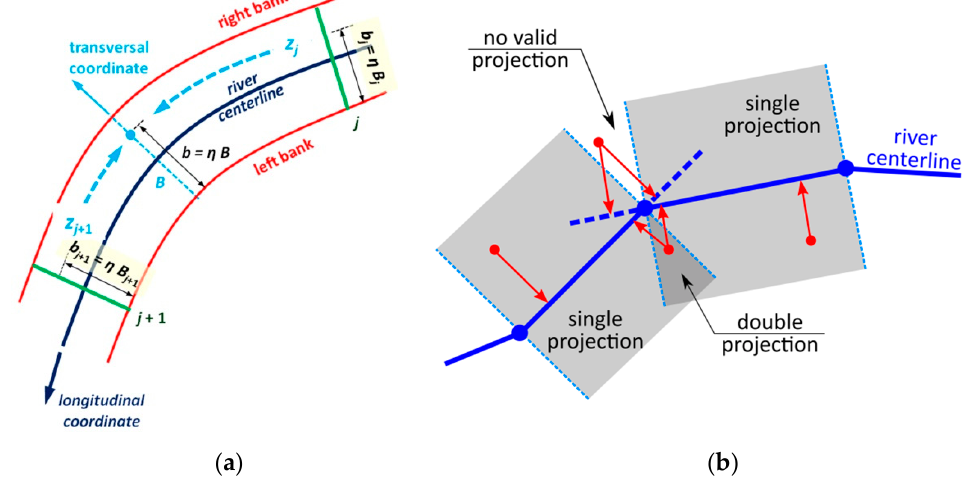
Figure 5. Interpretation of basic implemented algorithms: ( a ) interpolation in channel-oriented coordinates; ( b ) empty and double projection zones.